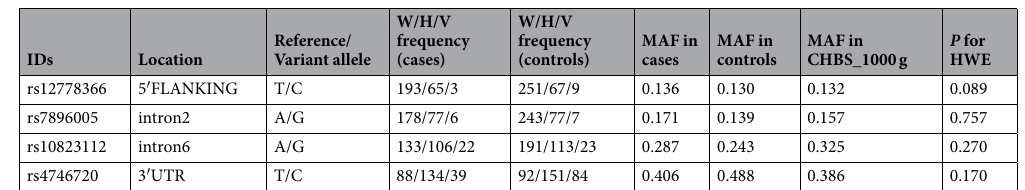
Table 2. Characteristics of the four SNPs included in the current study. Abbreviations: W, wild type homozygote; H, heterozygote; V, variant homozygote. MAF, minor allele frequency; CHB, Han Chinese in Beijing, China; HWE, Hardy-Weinberg